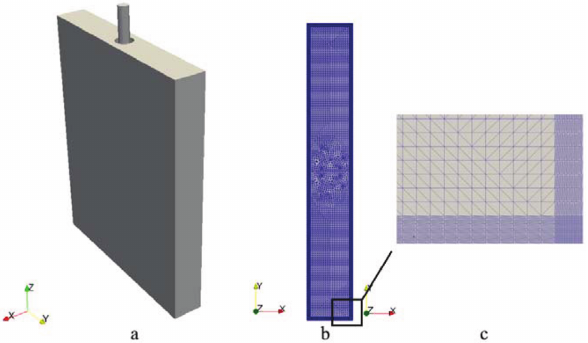
Figure 1: A schematic view of the slab domain (a), mesh of slab cross section at 0.8m from meniscus (b), and the enlarged view of the rectangular box in b